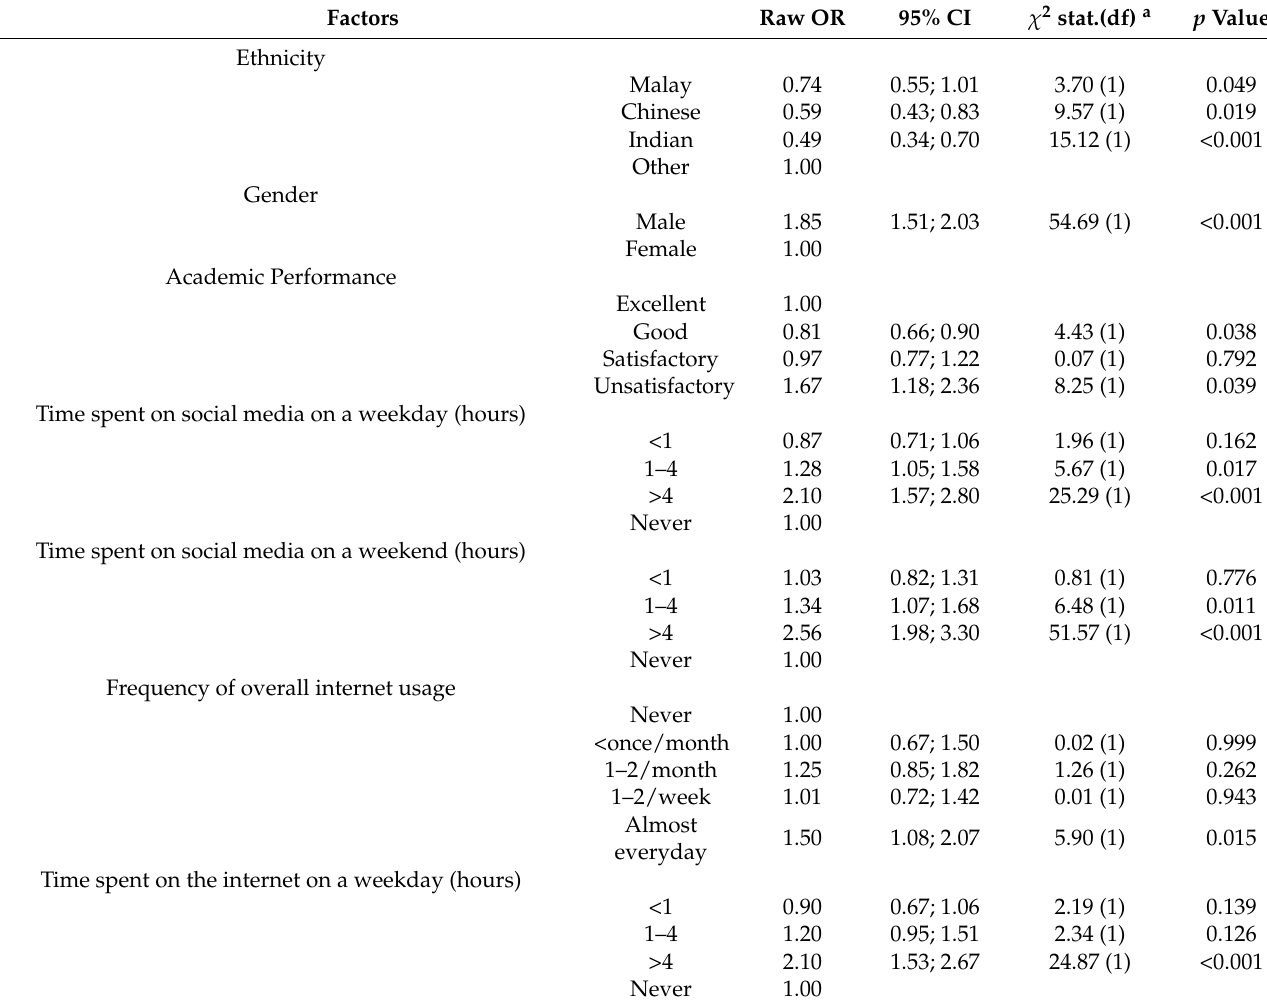
Table 5. Individual factors related to bullying